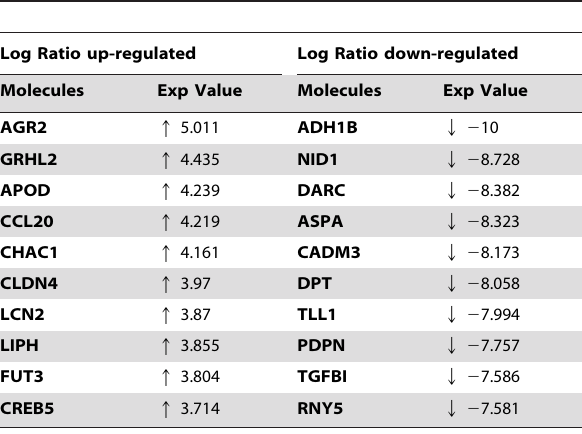
Table 2. Significant canonical pathways associated with differentially expressed genes.